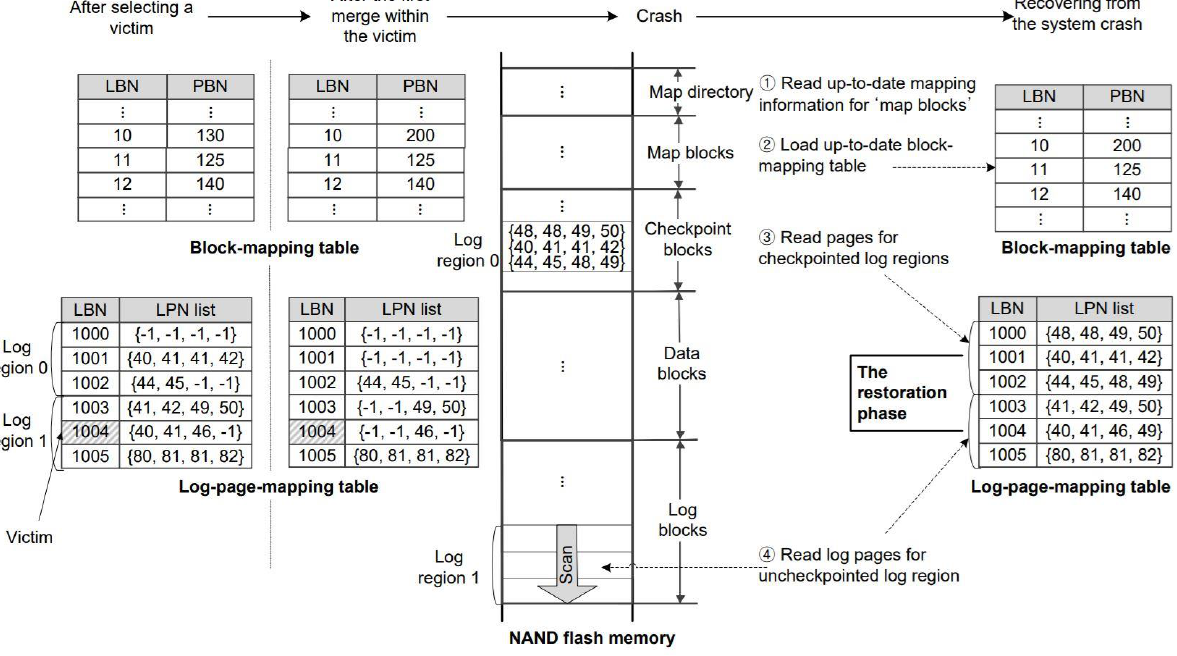
Figure 4. Recovery process.